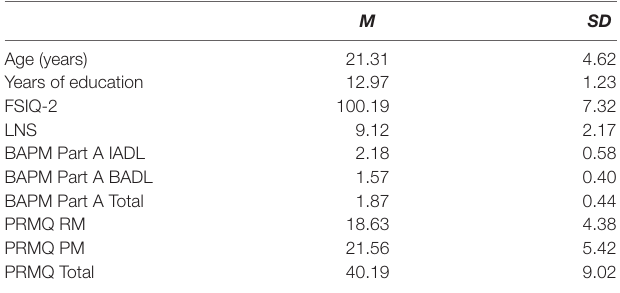
TABLE 1 | Mean scores and standard deviations of sociodemographic and cognitive variables ( N =